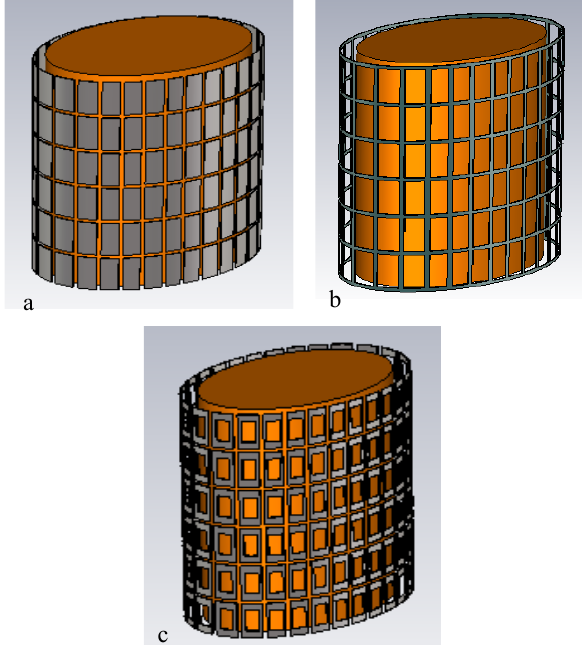
Figure 1: Simulated cloak structures. a) patch structure b) mesh structure c) ring